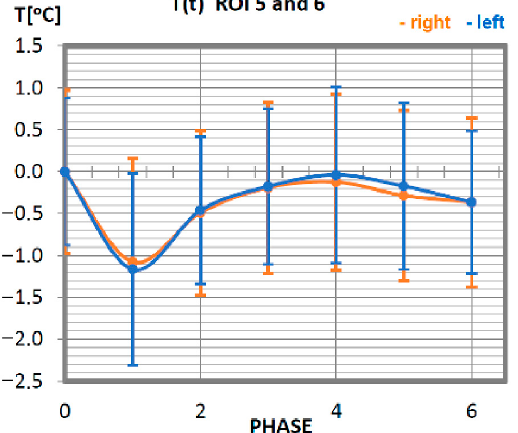
Figure 5. Temperature time (0 to 6 phase of training according to methods) changes of the triceps muscle of the arm obtained before and after training using a rowing ergometer for the studied group of athletes.